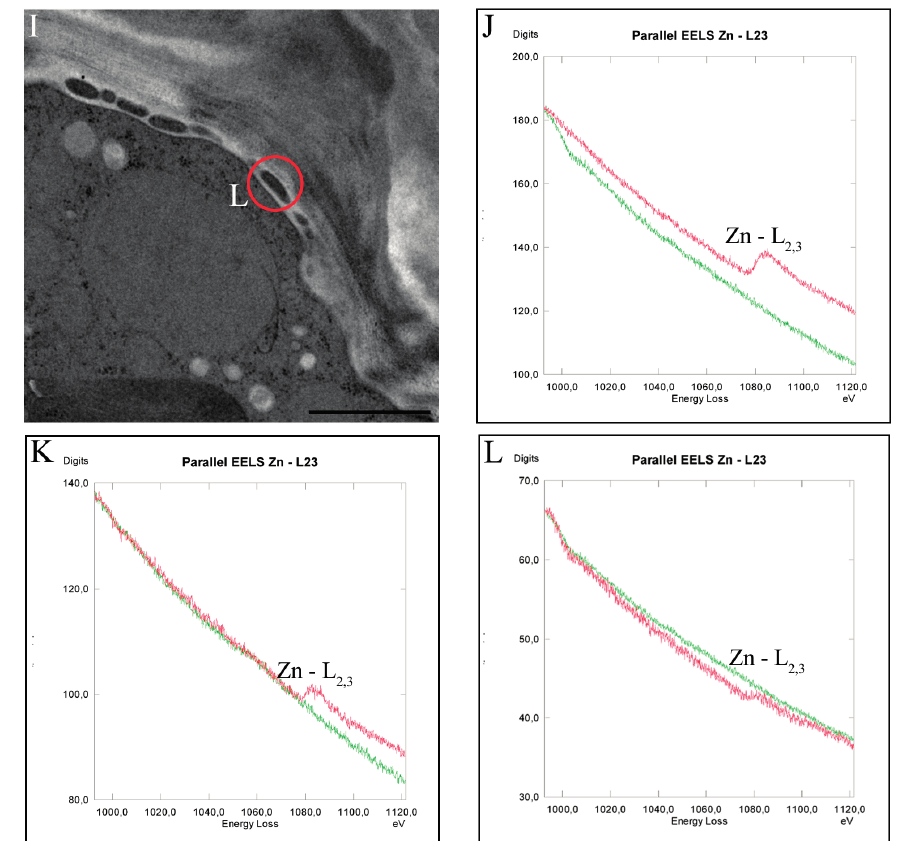
Figure 7. TEM micrographs of measurement sites ( A , E , I ) and EEL-spectra measured in Desmidium cells treated with 10 µM Al 2 (SO 4 ) 3 ( B – D ), with 0.3 µM CuSO 4 ( F – H ), and with 10 µM ZnSO 4 ( J – L ), respectively, for 21 days. Measurement areas of the single spectra are indicated as circles in the respective TEM micrographs. The red graphs represent the measurements indicated, the green graphs show control spectra; ( B ) Al is detected by the K-edge in a precipitation in the secondary cell wall; ( C ) in dark inclusions in the chloroplast and ( D ) in starch grains (measurement area not shown in TEM micrograph); ( F ) Cu is measured by L 2,3 -edge in the secondary cell wall; ( G ) in electron dense inclusion in the chloroplast and ( H ) in a starch grain; ( J ) Zn L 2,3 -edges were identified in the cell wall itself; ( K ) in electron dense inclusions of the chloroplast (measurement areas for ( J , K ) not shown); and ( L ) In abnormal depositions underneath the secondary cell wall. Bar = 2